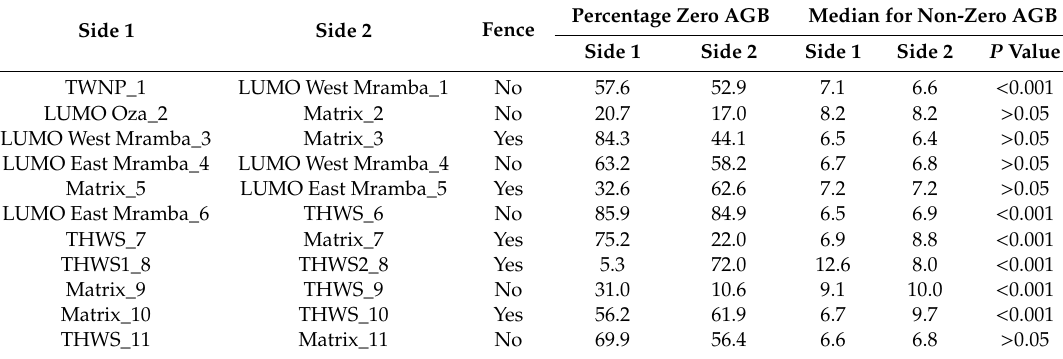
Table 4. Percentage of zero woody aboveground biomass (AGB) and median AGB for non-zero AGB pixels. P value refers to the Wilcoxon test results made for the non-zero AGB values. Numbers in the end of land-use region names refer to the numbers of bu ff ers in Figure